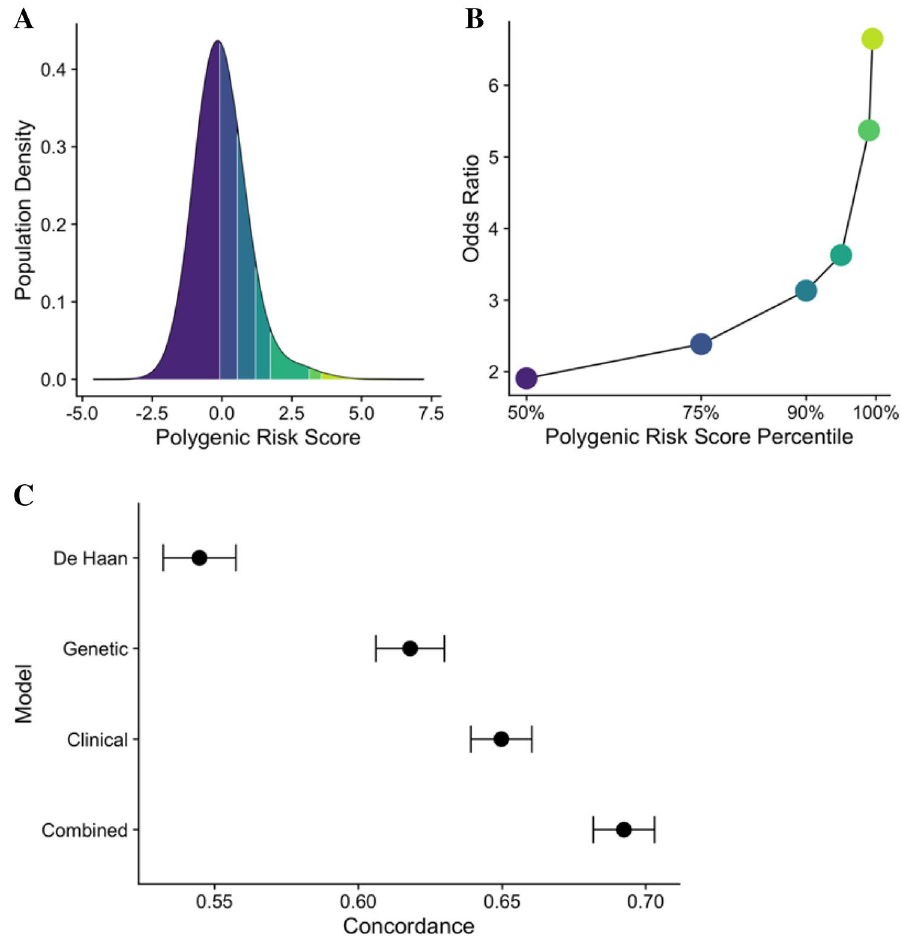
Figure 4. Prediction of venous thromboembolism. ( A ) and ( B ) Show the rates of venous thromboembolism derived from Fine-Gray models for the genetic and clinical score, respectively. ( C ) Shows 10-year event rates for venous thromboembolism, stratified by both the clinical score and genetic score. The I bars represent 95% confidence